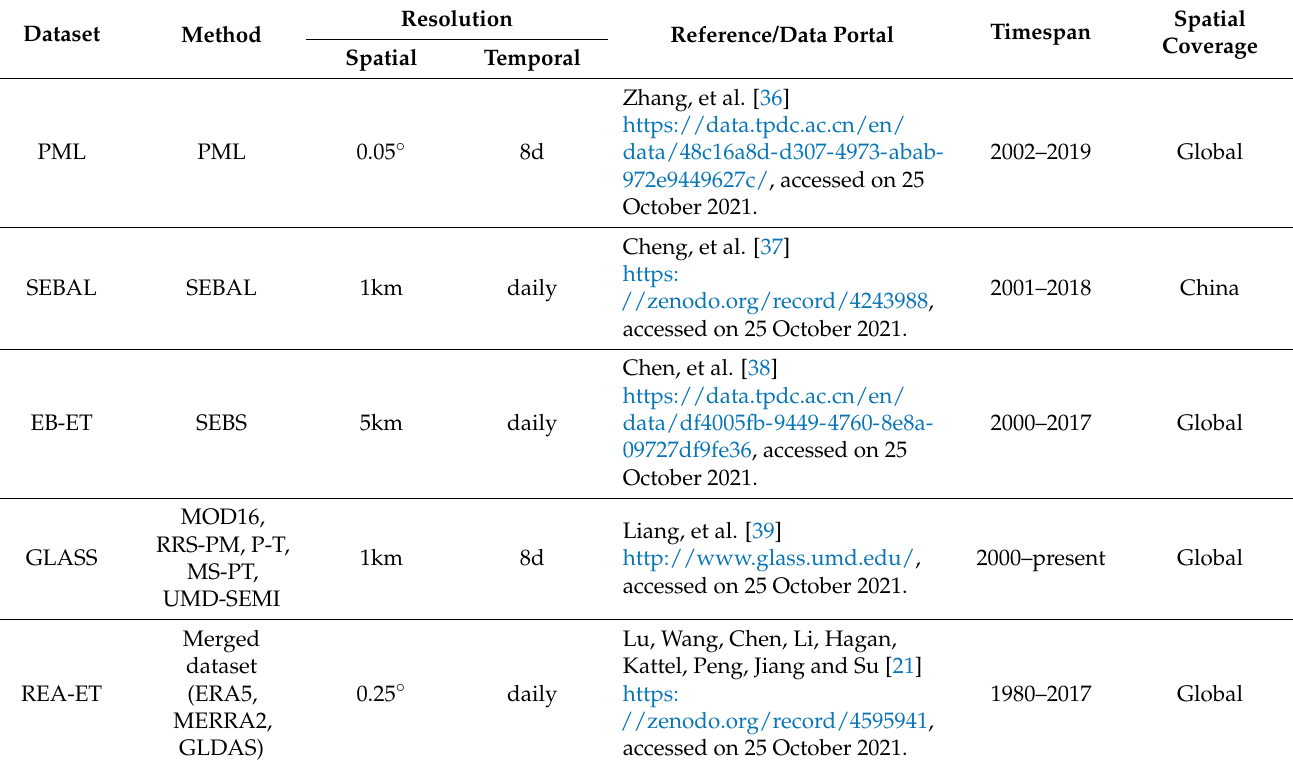
Table 3. Summary of ET